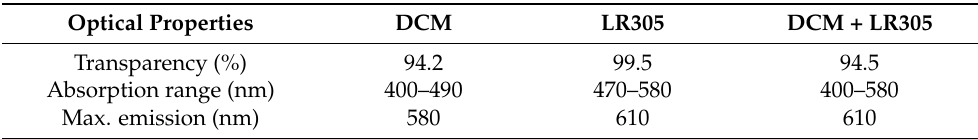
Table 1. Optical properties of the films manufactured, using different doping molecules: DCM, LR305, and DCM +